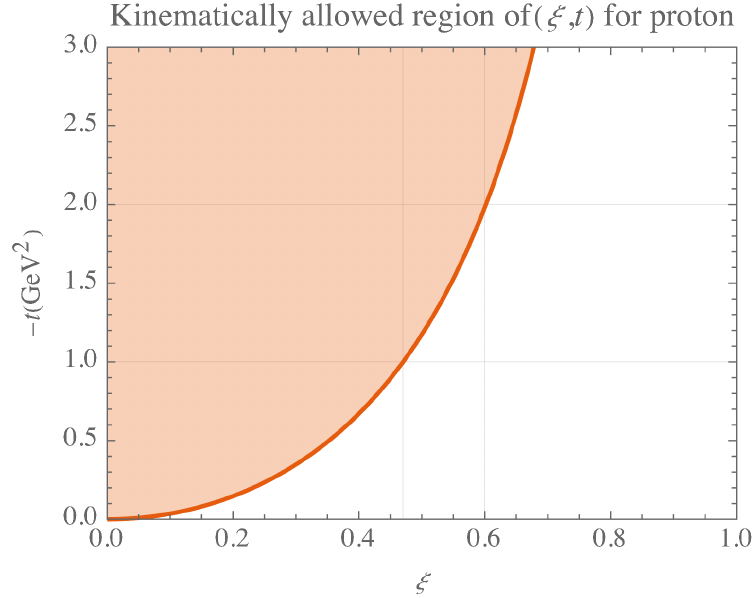
Figure 1 . A plot showing the kinematically allowed region on the ( ξ, t ) plane for proton scattering with proton mass M = 0 . 938 GeV. Typically, larger momentum transfer | t | is needed to reach the region with larger skewness ξ